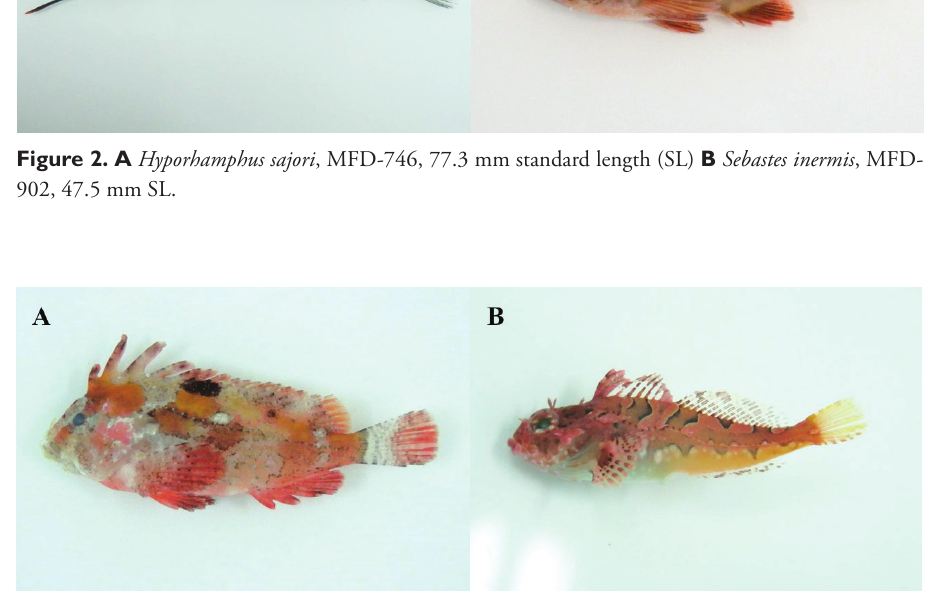
Figure 3. A Hypodytes rubripinnis , MFD-669, 42.9 mm SL B Furcina osimae , MFD-627, 29.3 mm